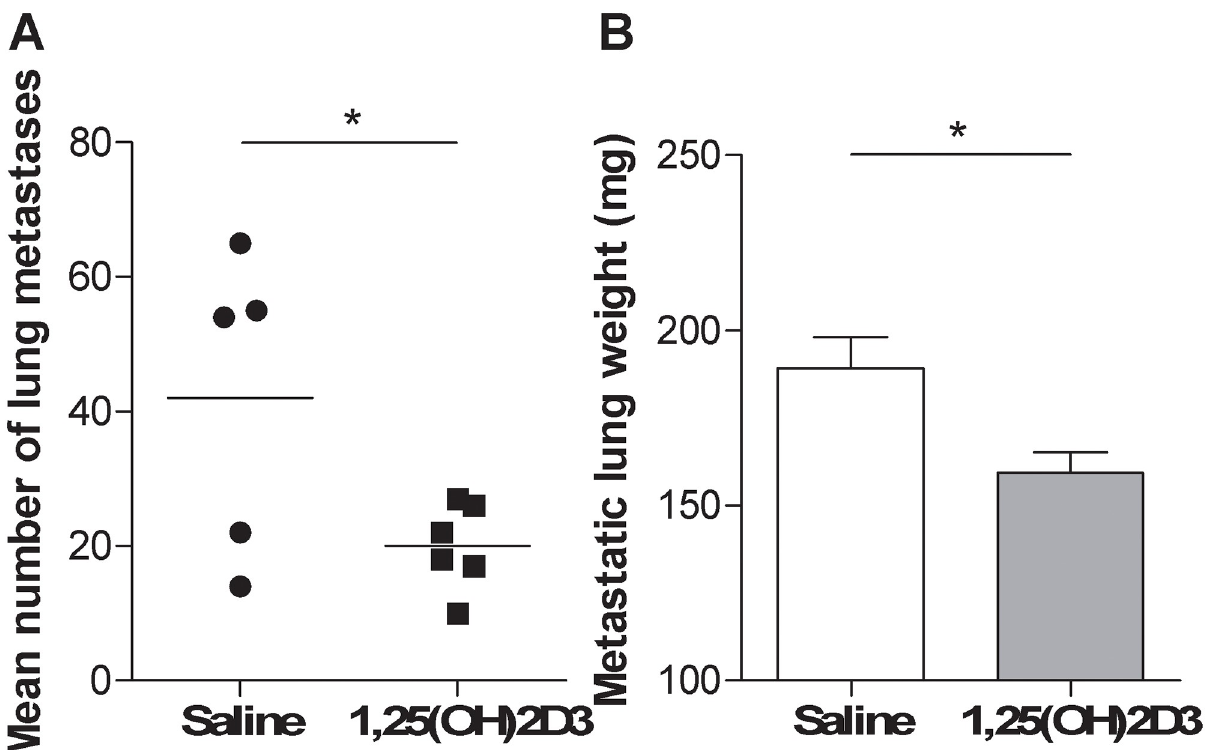
Fig 2. Aerosolized supplementation of 1,25(OH)2D3 reduced metastatic tumor growth in the lung. MC-38 colon cancer cells were injected in C57BL/6 mice and mice were treated with aerosolized saline or 1,25(OH)2D3 as described in Materials and Methods. At the end of the experiment was evaluated (A) in saline-treated group (n = 5) and in 1,25(OH)2D3-treated group (n = 6) mean number of lung metastases and (B) in saline-treated group (n = 6) and in 1,25(OH)2D3-treated group (n = 6) metastatic lung weight. Unpaired t test; � p < 0.05.